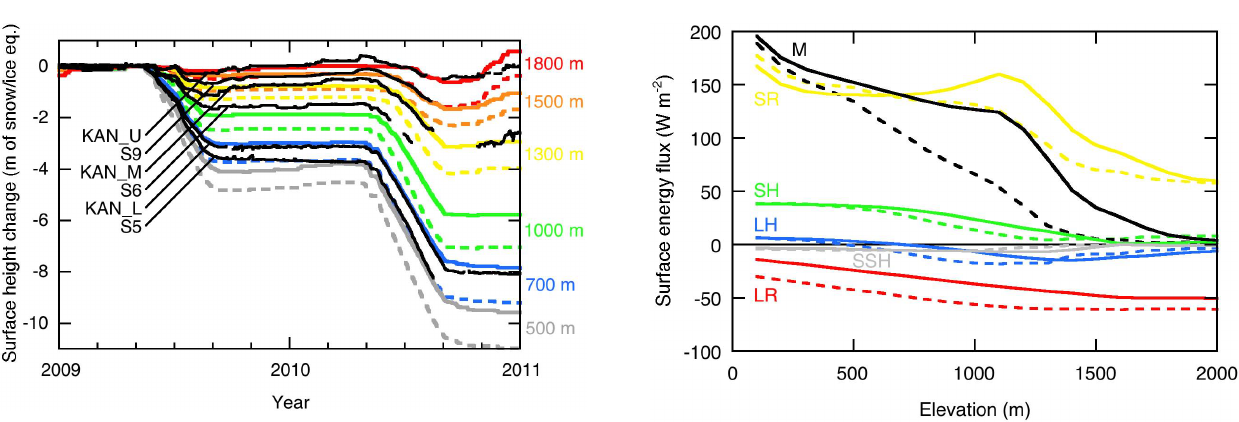
Fig. 6. Mean SEB components for June, July and August in 2009 (dashed lines) and 2010 (solid lines) versus elevation. Net short- wave radiation: yellow, net longwave radiation: red, sensible heat flux: green, latent heat flux: blue, sub-surface heat flux: grey, and energy available for melt: